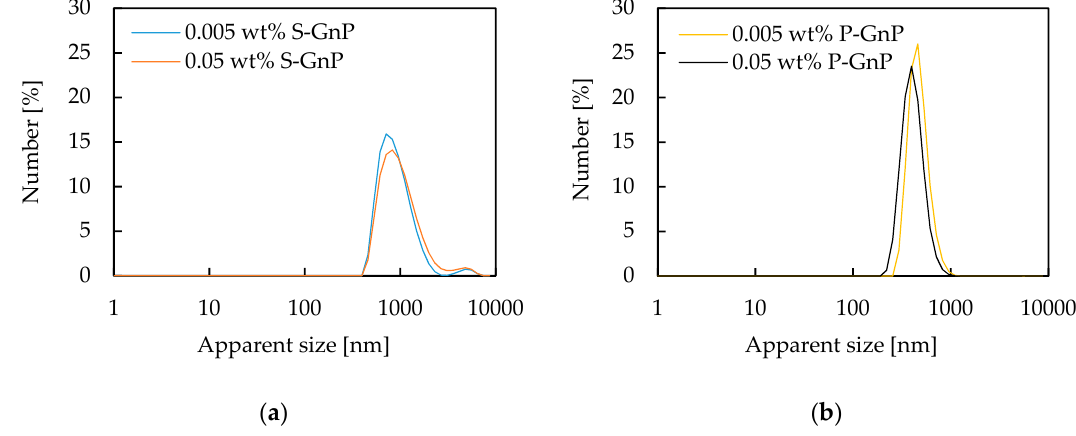
Figure 1. Size distribution by number for the S-GnP ( a ) and P-GnP ( b ) dispersions in water.